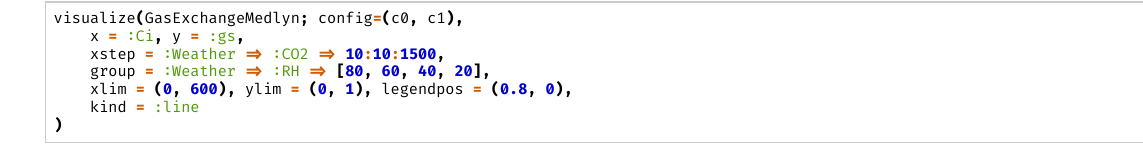
Figure A5. Script for generating Figure 2b. visualize() function internally runs simulate() and render a plot using the output. Note that a configuration used here is the baseline c0 partially overridden by the calibrated c1 . x and y options specify variables used for two axes of the plot. xstep option provides a range of value to compose a single curve, indicating atmospheric CO 2 concentration ( C a ) is ranged from 10µbar to 1500µbar. group option provides a group of treatments to render multiple curves, indicating four levels of relative humidity (RH) are used. xlim option sets the visible range of C i limited from 0µbar to 600µbar and ylim option sets the range of g s from 0 to 1mol H kind option for plot type can be either :line or :scatter